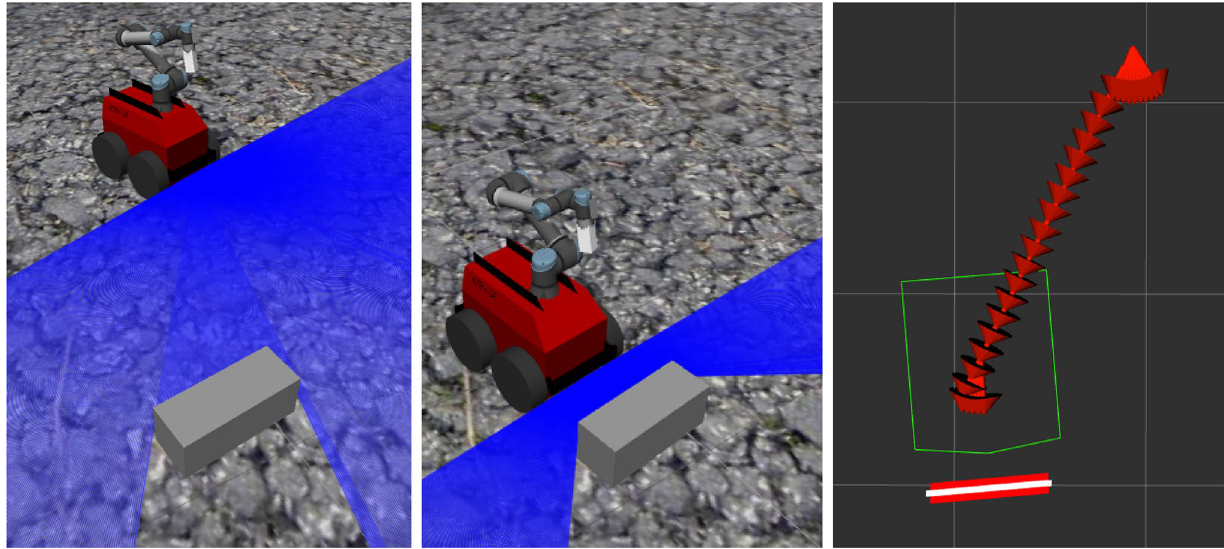
Fig. 10 Left: robot starting position; Center: robot final position (aligned with the brick surface); Right: the path calculated to perform the alignment using laser information as feedback